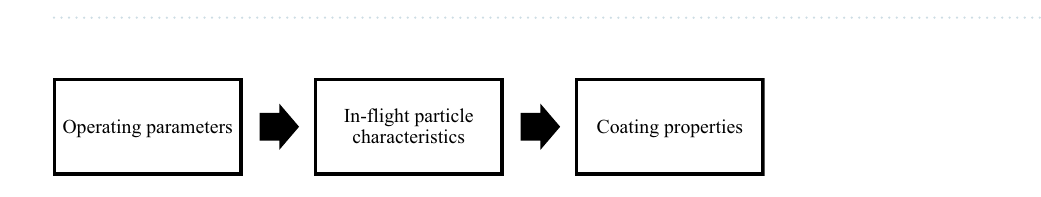
Figure 2. Three main aspects of an Atmospheric Plasma Spray